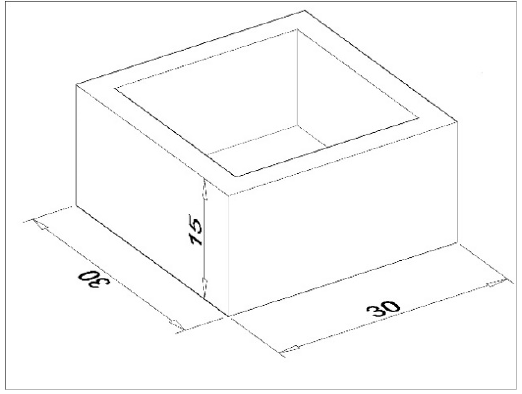
Figure 1. 3D model design and its nominal dimensions in millimeters (mm).